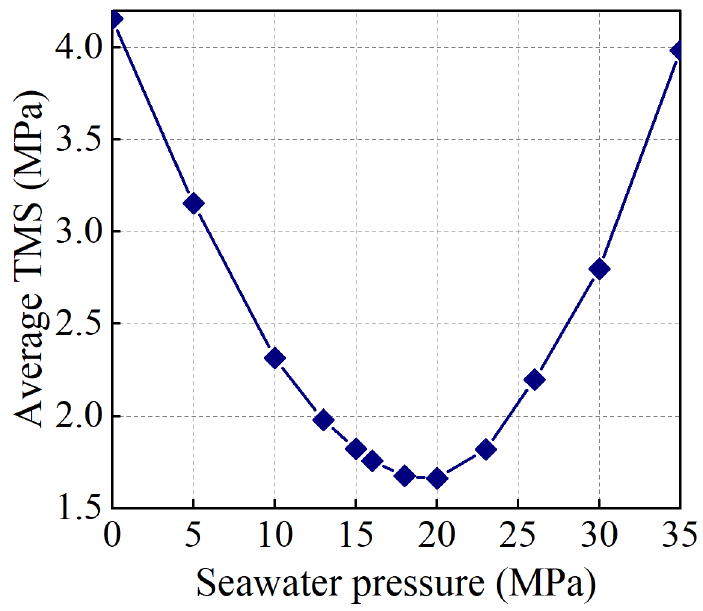
Figure 14. TMS in the SIS of the DSOF motor variation with seawater pressure based on the thermal